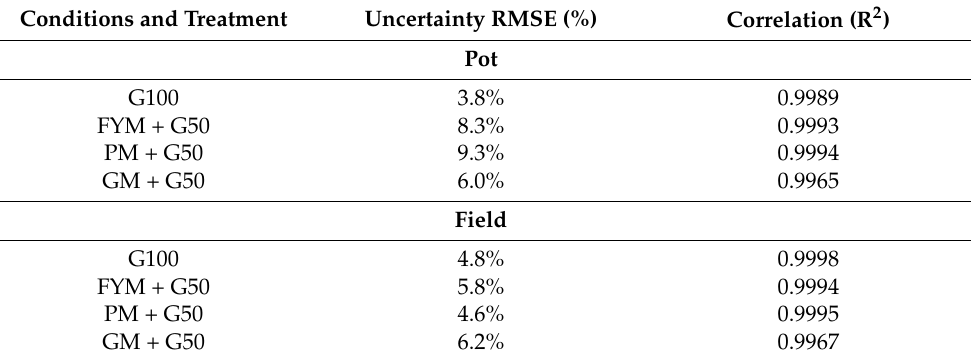
a correlation R 2 over 0.99 in all treatments (Table 7). Therefore, the model can be used to assess the impact of treatments on C sequestration over the long term, with a confidence of ±10%. Table 7. Evaluation of simulations of the impact of gypsum and organic manures on soil carbon in pot and field experiments at Jhang. Note: FYM = farmyard manure, PM = poultry manure, GM = green manure (all applied at 12 t ha − 1 ); G100 = 100% soil gypsum requirement; G50 = 50% soil gypsum requirement.